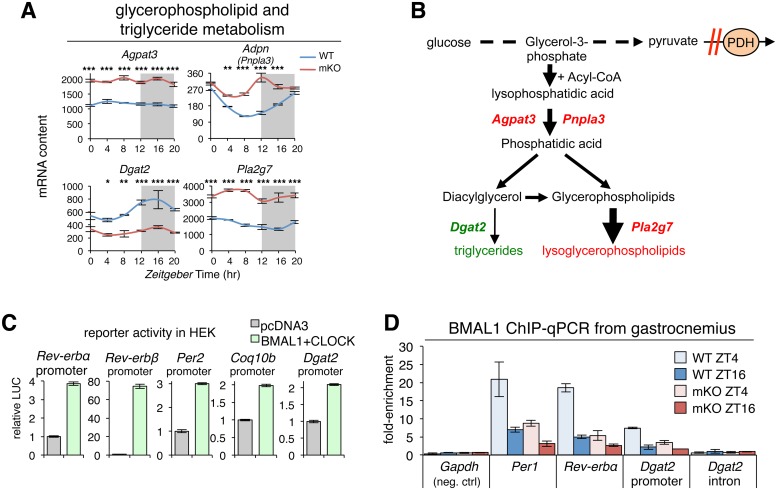
BMAL1 promotes diurnal muscle triglyceride synthesis by direct transcriptional activation of Dgat2.(A) Diurnal expression profiles in TA muscles of selected key regulators of glycerophospholipid and triglyceride metabolism (n = 3 × time point; mean ± SEM *p < 0.05, **p < 0.01, ***p < 0.001, 2-way ANOVA with Bonferroni correction; see also S7A Fig). (B) Scheme showing alterations identified in mKO muscles related to reduced TG content and increased lysoPLs. Increased glycolytic flux in the context of impaired PDH activity [7] channels glycolytic intermediates to lysoPL biosynthesis. Red = increased gene expression or metabolite abundance in mKO relative to WT; green = reduced gene expression or abundance. (C) Validation of BMAL1 transcriptional targets by cotransfecting HEK-293T cells with LUC reporter constructs containing muscle BMAL1 binding sites from known and putative target promoters linked to LUC, along with expression plasmids for BMAL1 and CLOCK or empty control vector (pcDNA3). Data is expressed as mean fold-change normalized to the empty vector (n = 3; ±SEM). (D) In vivo BMAL1 occupancy at target sites in WT and mKO gastrocnemius at ZT4 and ZT16 (mean fold-enrichment over IgG ± SEM; n = 2 pooled biological replicates for each of 2 independent ChIP-qPCR experiments). Underlying data can be found in supporting file S1 Data and at Gene Expression Omnibus (accession number GSE43071). BMAL1, brain and muscle ARNT-like protein 1; ChIP-qPCR, chromatin immunoprecipitation–quantitative real-time PCR; CLOCK, circadian locomotor output cycles kaput; HEK-293T, human embryonic kidney 293T; IgG, immunoglobulin G; LUC, luciferase; lysoPL, lysoglycerophospholipid; mKO, myocyte-specific loss of BMAL1; PDH, pyruvate dehydrogenase; TA, tibialis anterior; WT, wild type; ZT, Zeitgeber time.